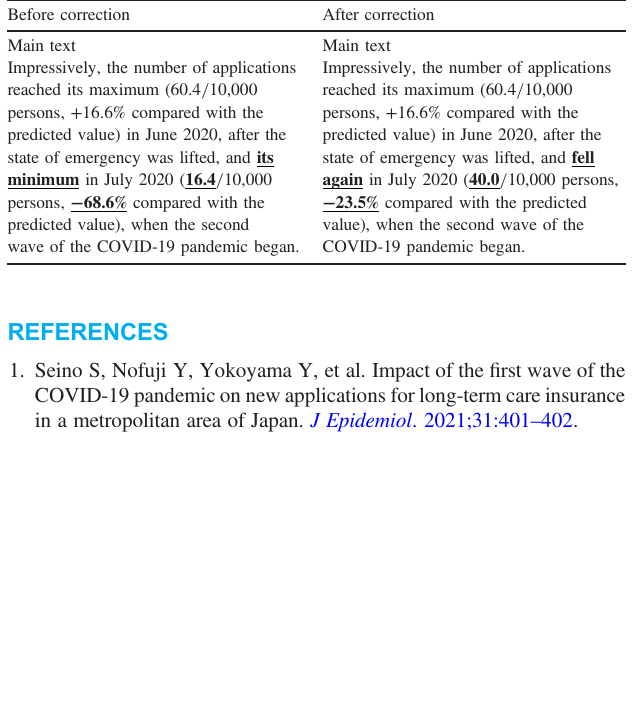
Table 1. Erratum Before correction After